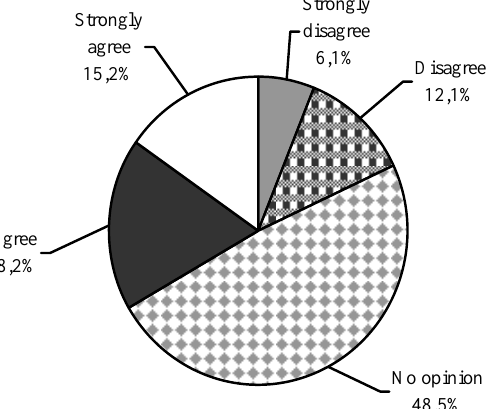
Fig 4 . Necessity for hinterland terminal as dry port concept for maritime container